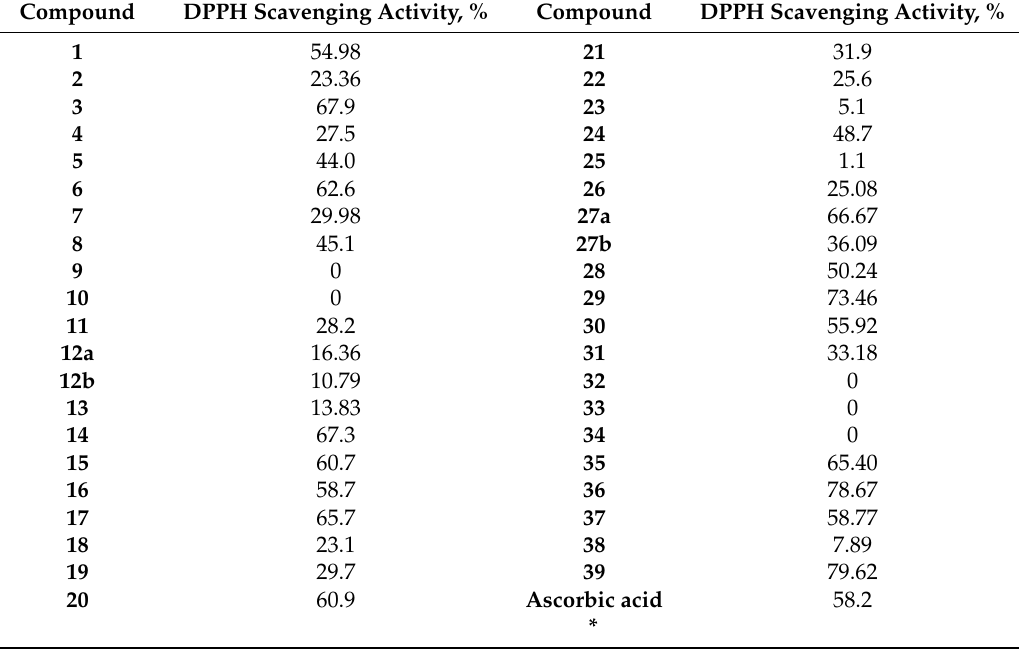
Table 1. DPPH scavenging activity of compounds 1 – 39